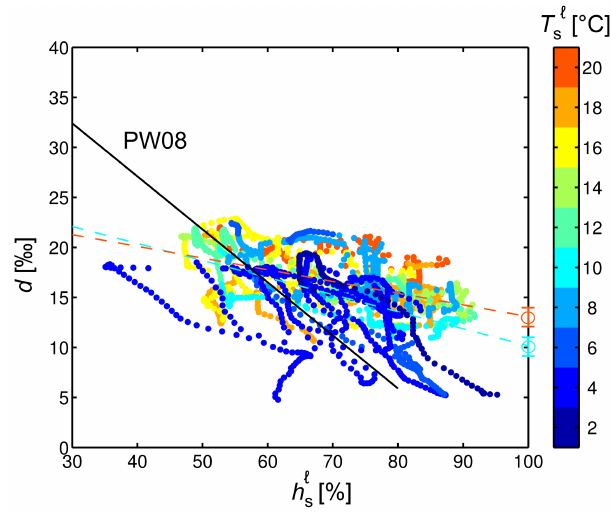
Fig. 11. The d – h ‘ s relations of HLA events. The colour bar indicates ground temperature T ‘ s . The dashed red line represents a fit to the data for T ‘ s ≥ 10 ◦ C: d = − 0 . 12 · h ‘ s + 25 and thus a diagnosed local soil moisture d ‘ s of 13‰ in the Rietholzbach area. The dashed blue line represents a fit to the data for T ‘ s < 10 ◦ C: d = − 0 . 17 · h ‘ s + 27 and thus a diagnosed local soil moisture d ‘ s of 10‰ in the Ri- etholzbach area. The black line shows the empirical relationship of Pfahl and Wernli